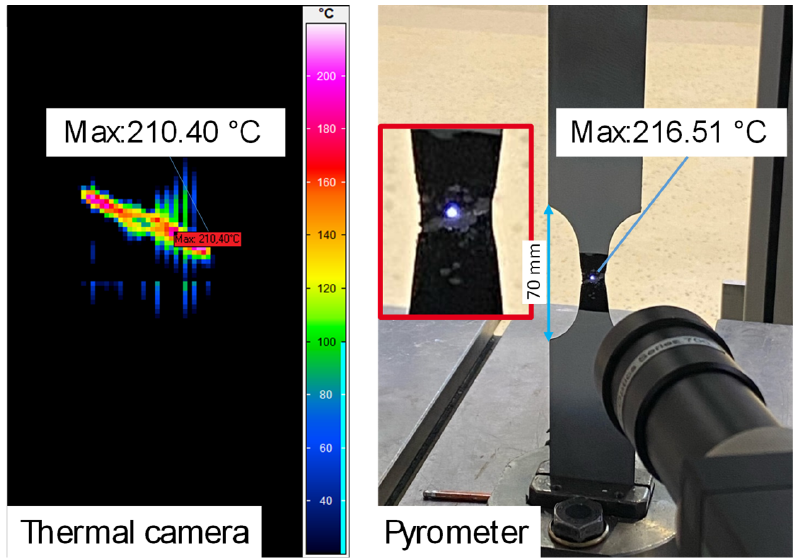
Figure 16. Comparison of temperature values obtained from the thermal camera and pyrometer for a nominal strain rate of 50/s.